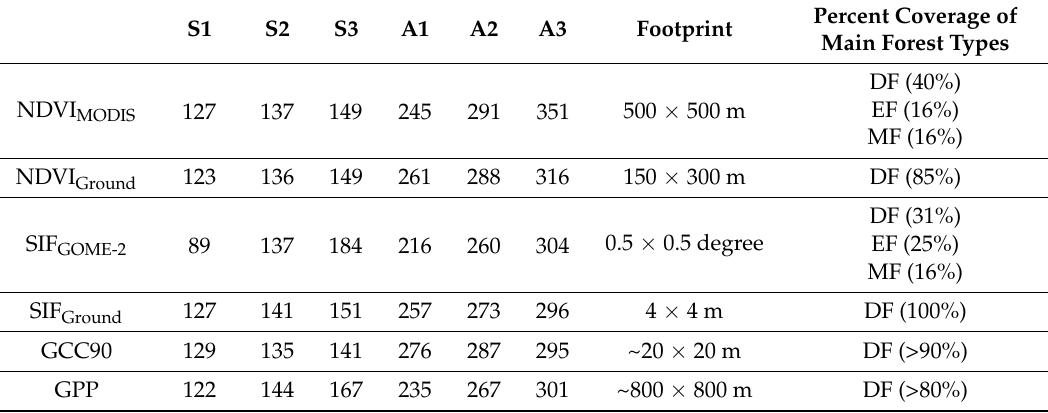
Table 1. The phenological metrics derived from the different time series at Harvard Forest in 2014. S1, S2 and S3 represent the dates (DOY) of the start of spring, middle of spring and end of spring, respectively; and A1, A2 and A3 stand for the dates (DOY) of the start of autumn, middle of autumn and end of autumn, respectively. “Percent coverage of main forest types” represents the main forest types (>15%) in their footprint. DF, EF and MF stand for deciduous, evergreen and mixed forest, respectively. See the text for the details. S1 S2